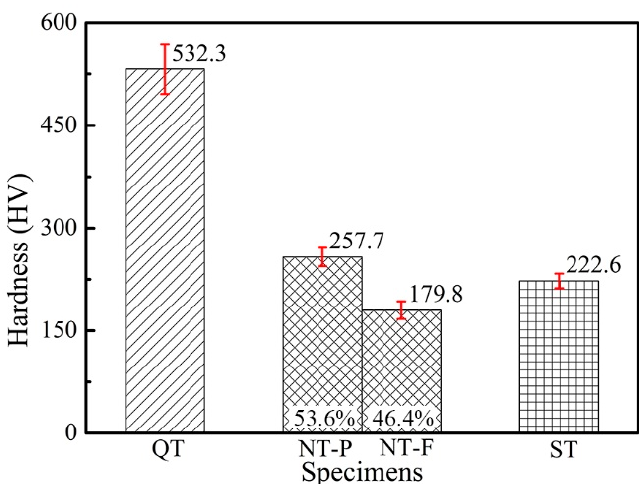
Figure 5. The microhardness with standard deviations of QT, NT, and ST. NT-P represents the pearlite in NT, NT-F represents the ferrite in NT. In addition, 53.6% and 46.4% are the volume fractions of pearlite and ferrite, respectively.